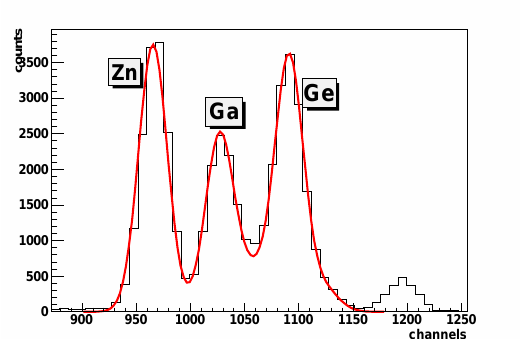
Fig. 1. Typical X-ray spectrum measured o (cid:11) -line for the reaction 6 Li + 64 Zn. It is possible to distinguish three main peaks which correspond to the K (cid:11) X-ray emission lines of Zn, Ga and Ge.